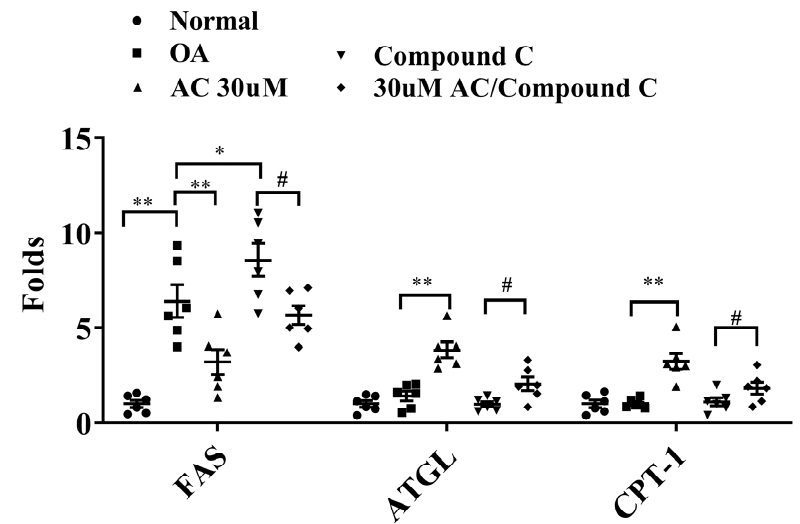
Figure 9. Acacetin (AC) attenuated lipid accumulation in FL83B cells. ( A ) Oil Red O staining re- vealed lipid accumulation (200× magnification). ( B ) FL83B cells treated with isopropanol and lipid accumulation was measured using the absorbance at OD 490 nm. Values are presented as mean ± SEM. * p < 0.05, ** p < 0.01 indicate significant differences compared to FL83B cells treated with oleic acid (OA). (scale bar = 100 µm).